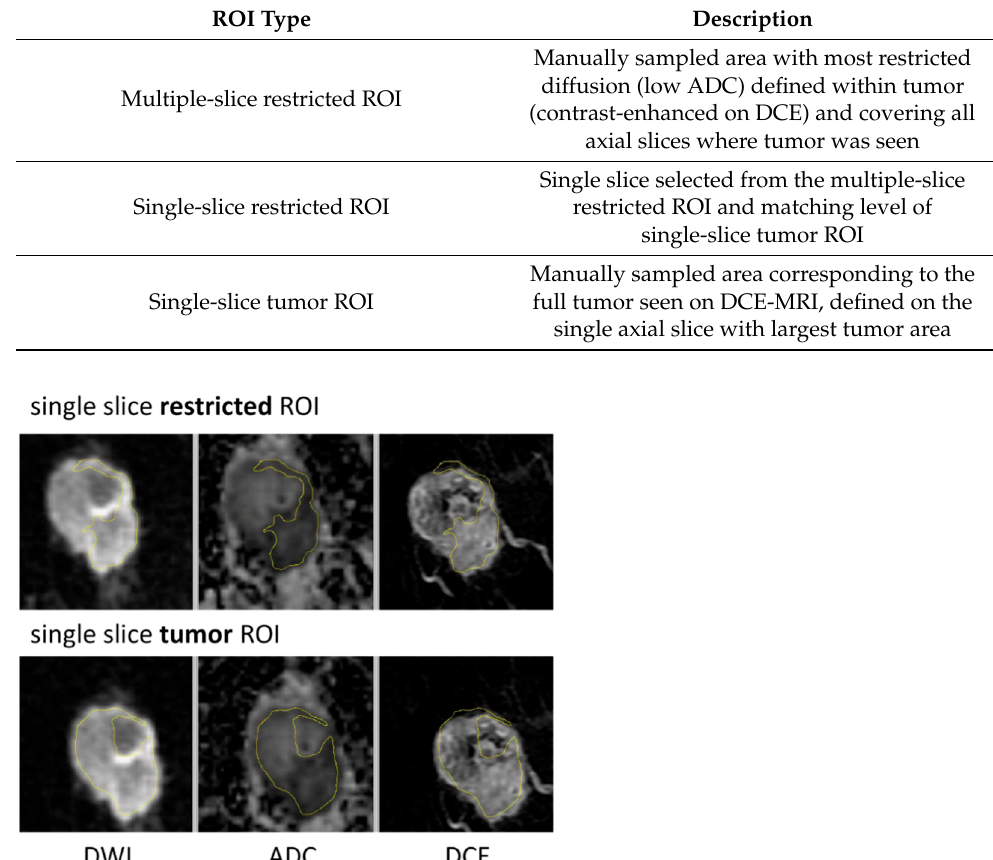
Table 1. ROI delineation Approach.